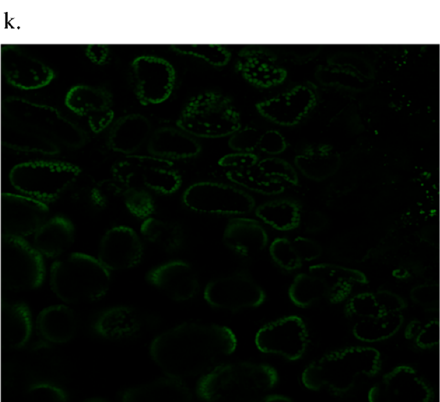
Figure 3. DsRed-tagged L. biglobosa (LbDsRed) and GFP-tagged L. maculans (LmGFP) in planta development of Westar cotyledons under controlled environment at 14 days post-inoculation. ( a ) Confocal microscopic observations of fluorescence protein-tagged Leptosphaeria isolates (10 × magnification). ( b ) Quantification of each isolate in planta at 3-, 7-, 11-, and 14- dpi. LbDsRed and LmGFP mycelia shown in fluorescent red and green colors, respectively. In graphs, red and green colors represent LbDsRed and LmGFP DNA, respectively. ( a , b ) LbDsRed inoculation; ( c , d ) LmGFP inoculation; ( e , f ) LbDsRed and LmGFP co-inoculation; ( g , h ) LbDsRed followed by LmGFP inoculation with one day interval; ( i , j ) LmGFP followed by LbDsRed inoculation with one-day interval; ( k ) Chlorophyll